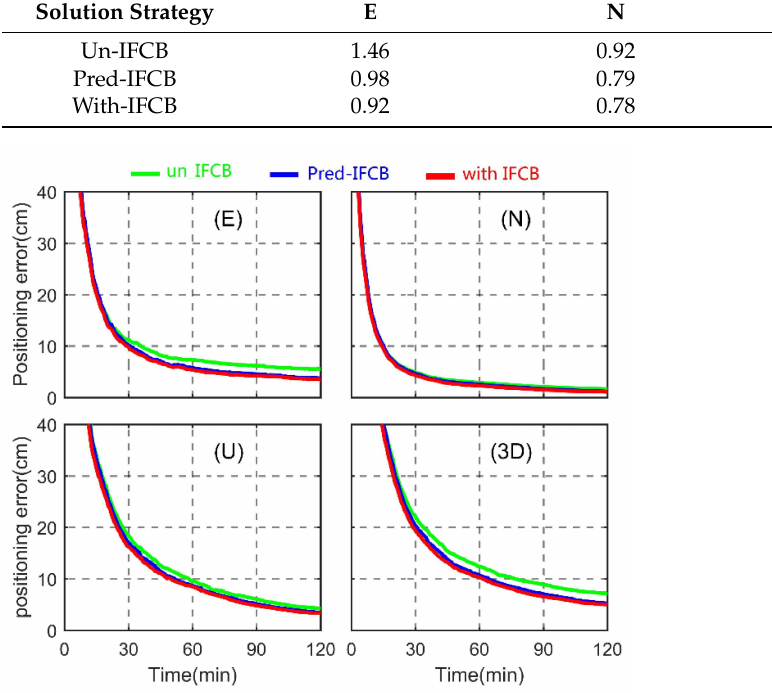
Figure 10. Average convergence time series of static PPP for east (E), north (N), up (U) and three dimensional (3D)